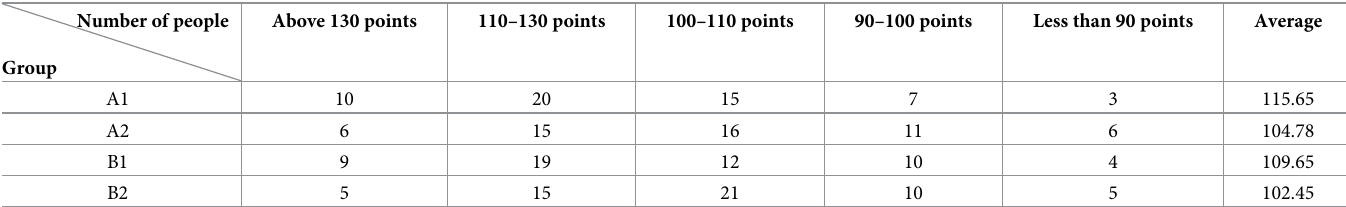
Table 11. The efficiency of logistics outlets in the rural e-commerce